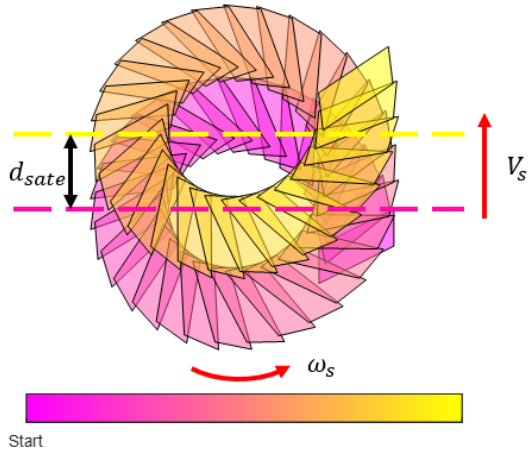
Figure 10. Blank part filling diagram.